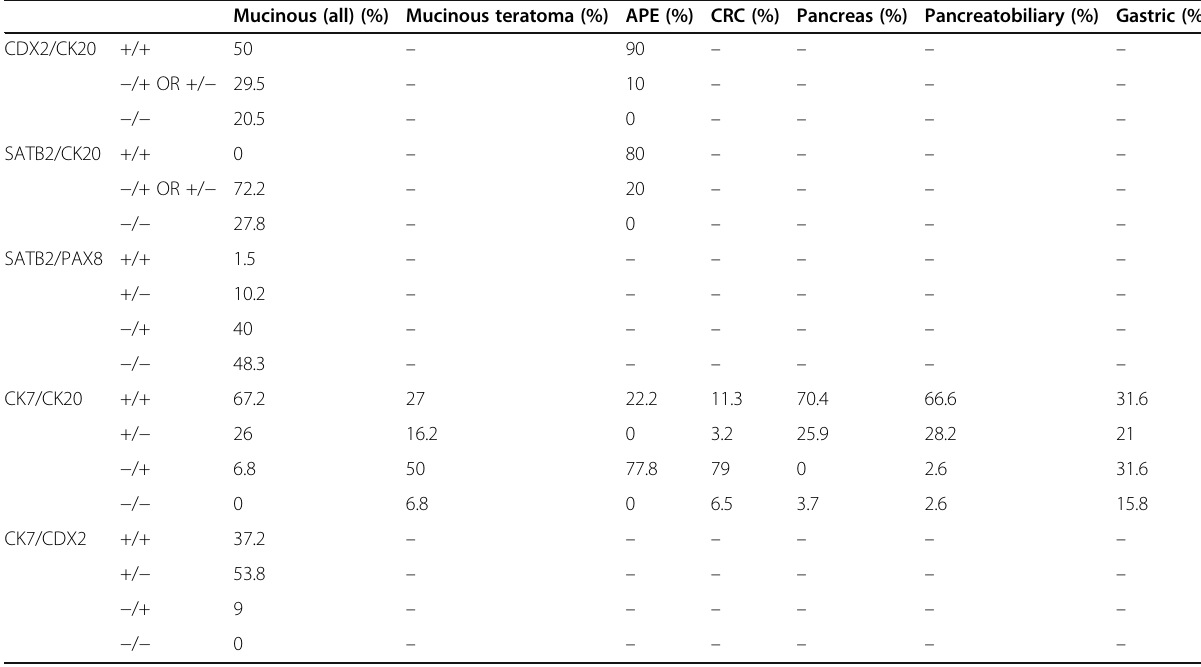
Table 5 Immunohistochemical results of the coordinate